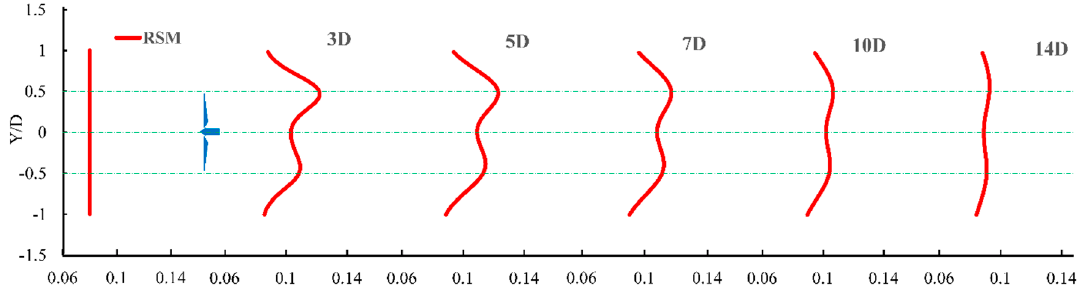
Figure 13. Horizontal distribution of turbulence intensity simulated by RSM.